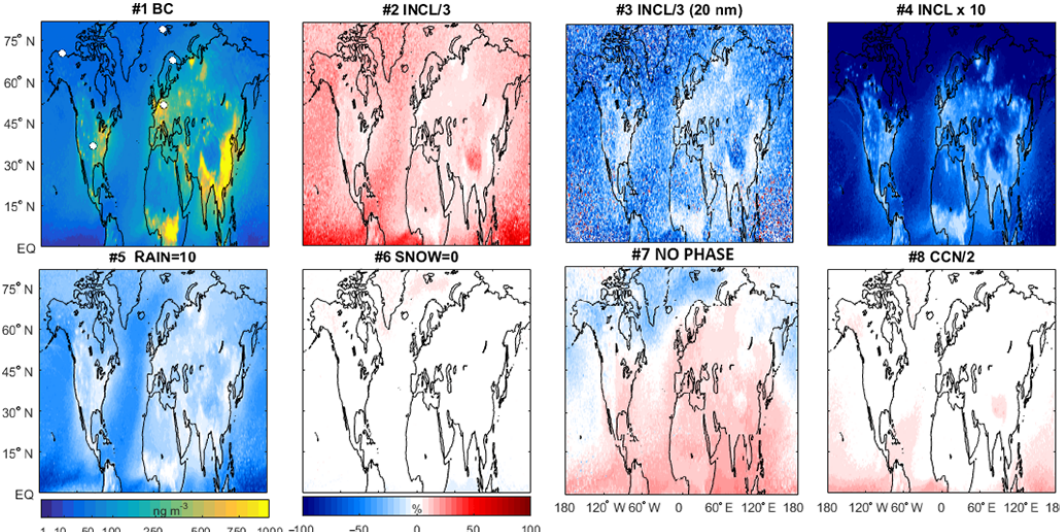
Figure 7. Annual average BC concentration in the lowest model layer (0–100m) for the reference simulation (top left) for the year 2007. White circles mark the locations of the measurement stations used for model comparisons. The other panels show the relative difference to this reference version (in %) for the seven other simulations using parameter settings from Table 4. Table 4. Aerosol specifications for the eight simulations done for BC. The first four columns report the aerosol removal parameters used, the following columns show the median concentration (ngm − 3 ) at each station and the last column reports the median of all modeled values. Italicised values: the value for each station that is closest to the observed values (bottom row), bold values: default coefficients, and underlined values: changed